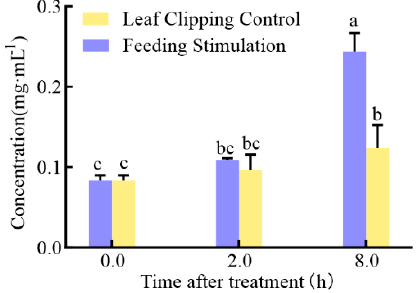
Figure 6. Total flavonoid concentration at different times after treatment. The data involved were the mean ± SD (n = 3). The same letter means there is no significant difference at the p < 0.05